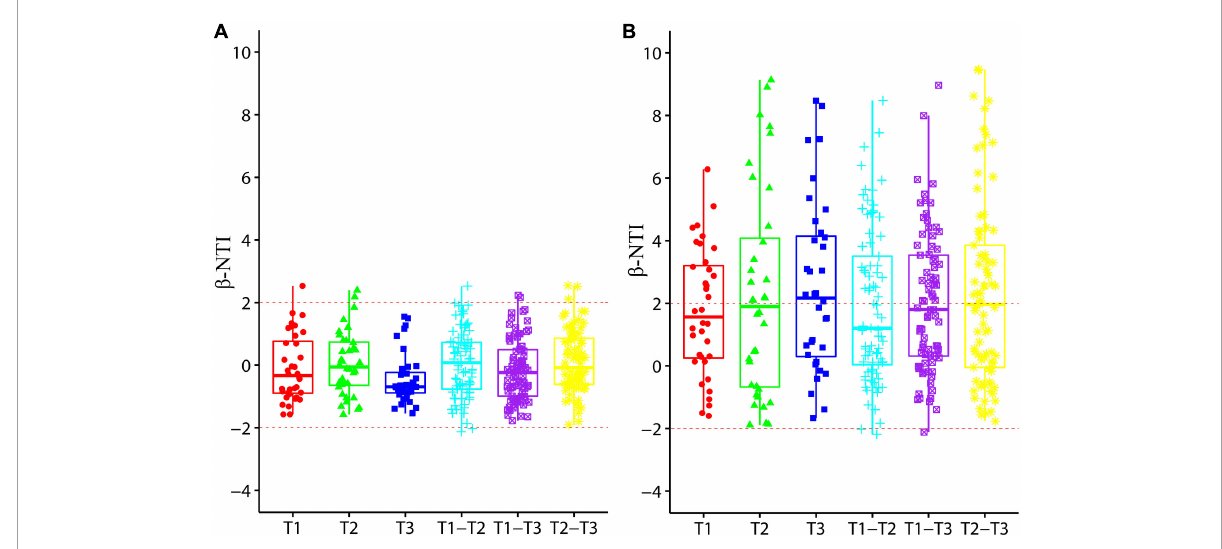
FIGURE6 Box plots representing values of β -nearest taxon index ( β -NTI) for ammonia-oxidizing archaea (AOA) (A) and ammonia-oxidizing bacteria (AOB) (B) communities from different sampling times. T1, T2, and T3 represent community comparison at three different sampling times, and T1-T2, T1-T3, and T2-T3 represent community comparison between different sampling